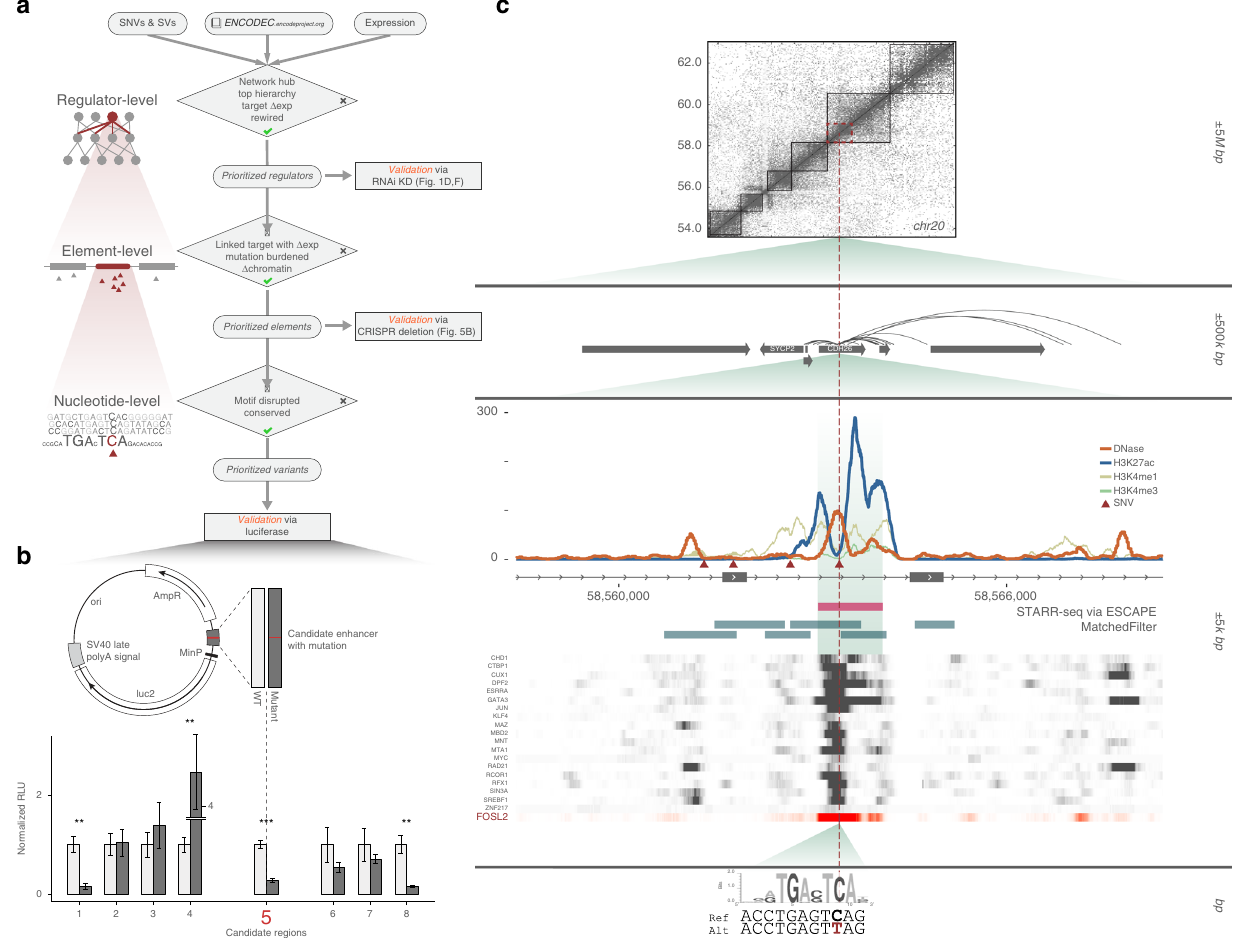
Fig. 6 Variant prioritization and validation. a A stepwise prioritization scheme for genomic regulators, elements, and variants, using the ENCODEC resources. At each step of prioritization, we indicate criteria for prioritization, as well as the applicable validation assay. b Small-scale validation of prioritized variants using a luciferase reporter assay. Candidate region 5 showed the most signi fi cant degree of differential expression and was selected for follow-up analysis. c Multiscale integrative analysis of candidate region 5 with assorted functional genomics data. The affected region is observed in the context of large-scale Hi – C linkages (top), as well as element-level signal tracks of histone modi fi cation marks and DNase hypersensitivity together with various TF binding events (middle), and nucleotide level disruption of the FOSL2 motif